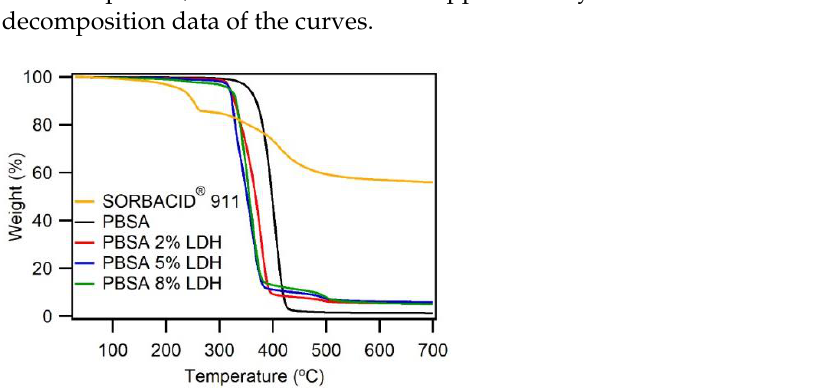
Figure 1. SEM images collected of PBSA and PBSA nanocomposite films with 2 wt%, 5 wt%, 8 wt% LDH demonstrating the dispersion of the LDH particles in the films.